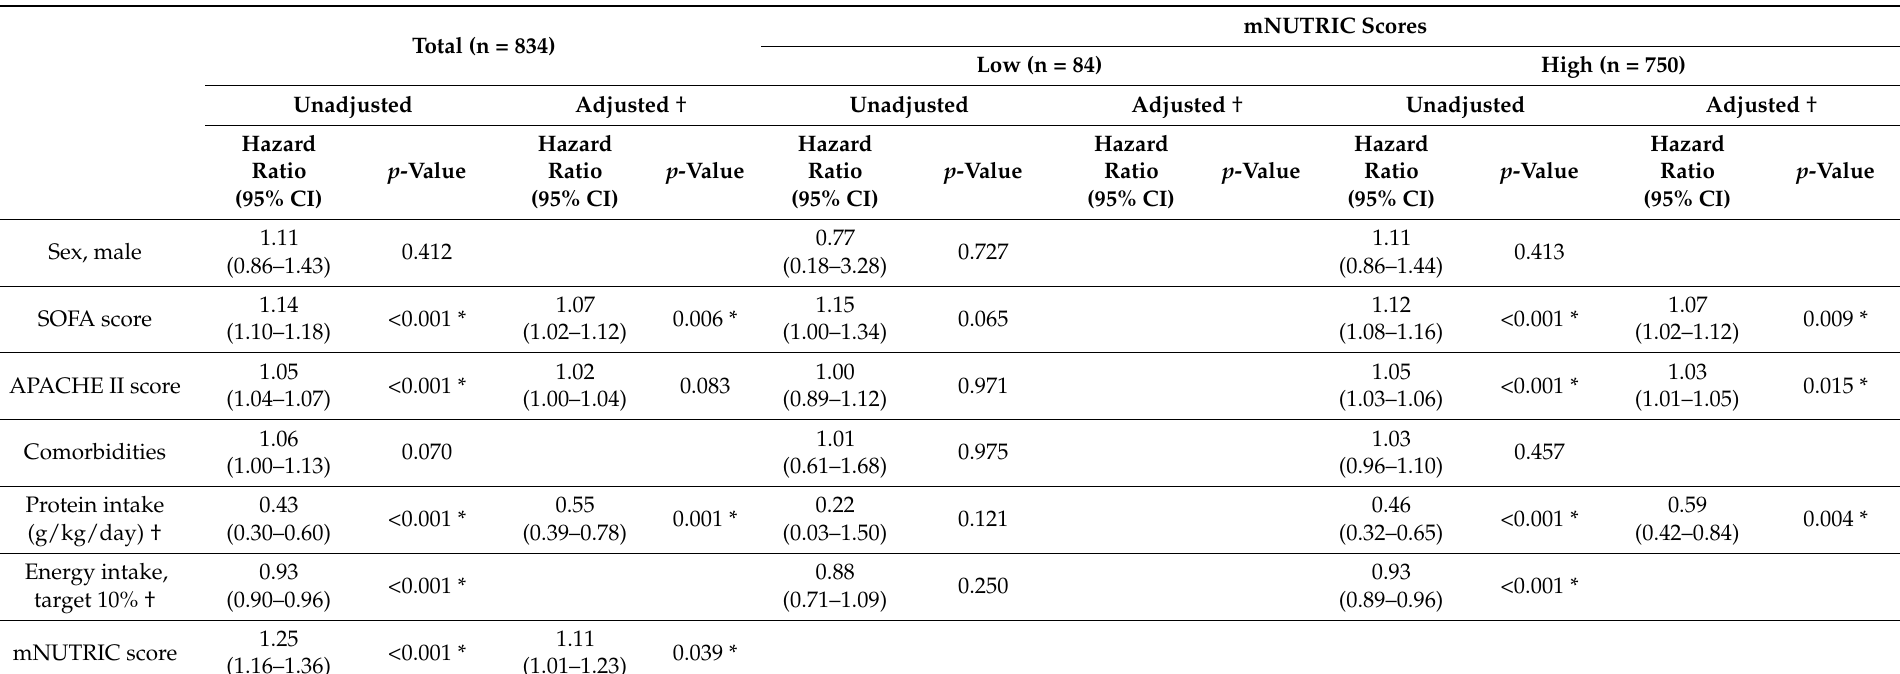
Table 2. Association between in-hospital mortality and nutrition supply in patients with sepsis one week after sepsis onset. Total (n =